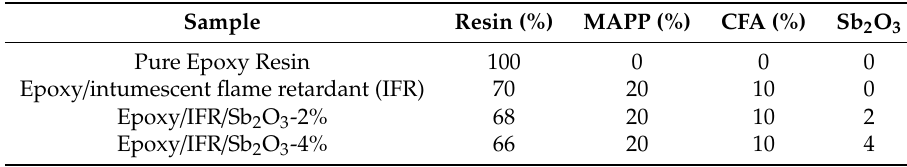
Table 1. Composition of the intumescent flame retardation